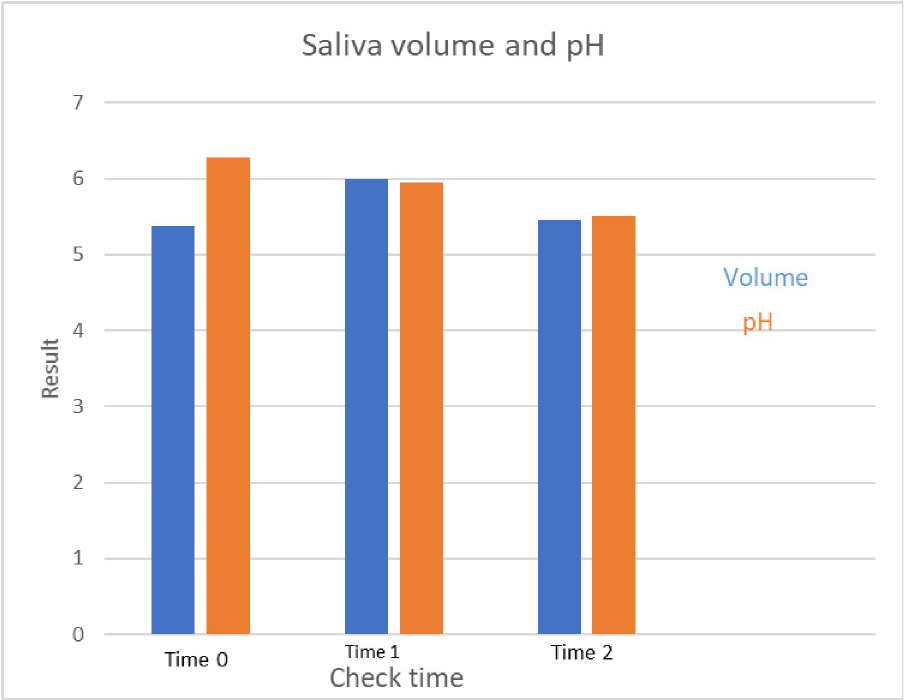
Fig 3. Saliva volume (ml) and pH (-log([H+]) at different time points; time 0 (Just prior to MC consumption), time 1, one week following MC consumption and time 2, four weeks following MC